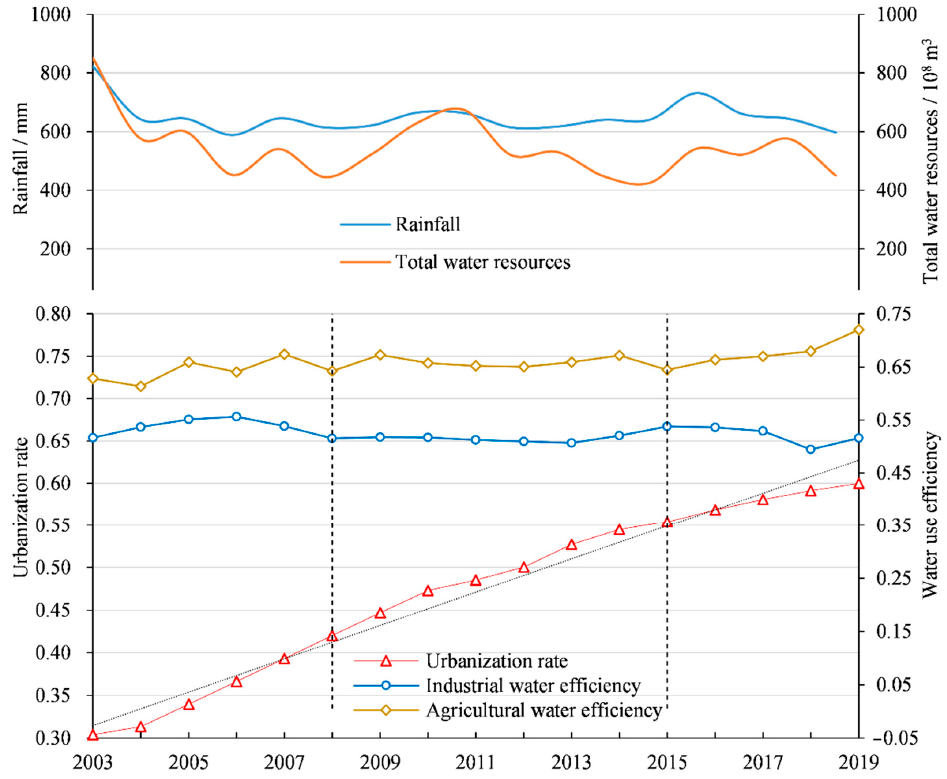
Figure 2. Trends in rainfall, total water resources, urbanization rate and industrial and agricultural water use efficiency.